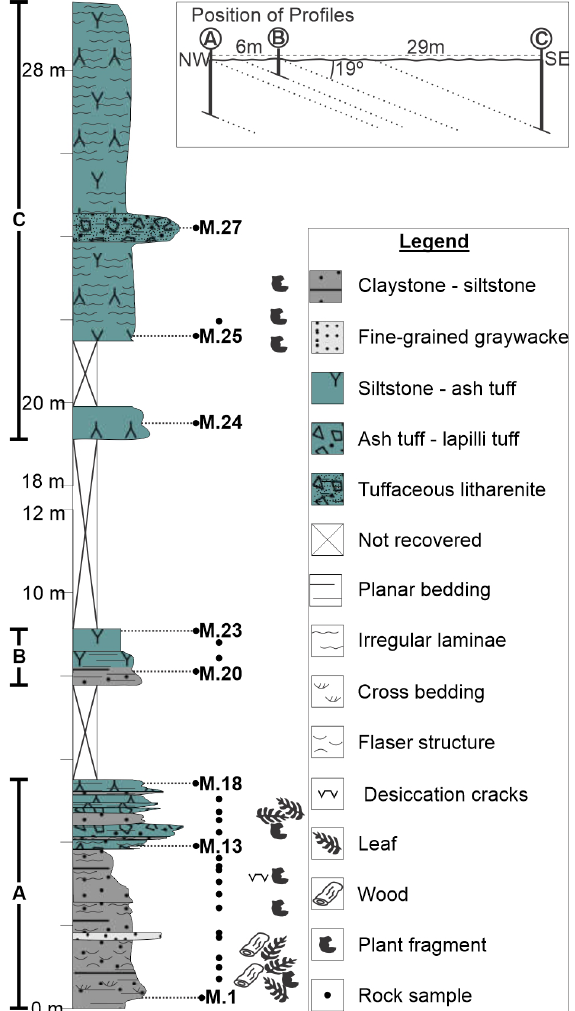
Figure 3. Composite lithostratigraphic profile of the Cerro Negro Formation in the north-central portion of the President Head Peninsula, Snow